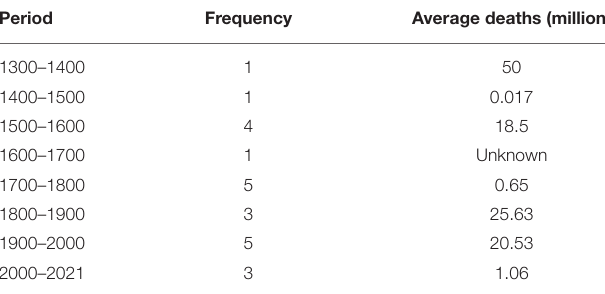
TABLE 2 | Pandemics frequency and average